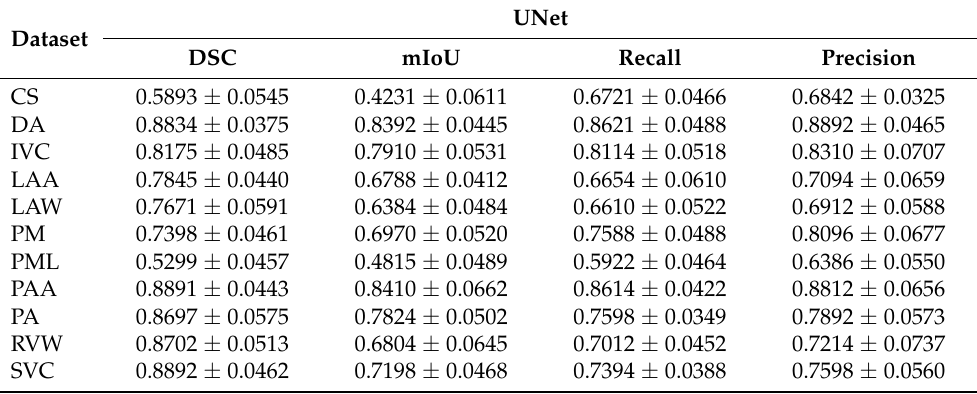
Table 3. Obtained segmentation results of different cardiovascular structures for UNet network architecture.